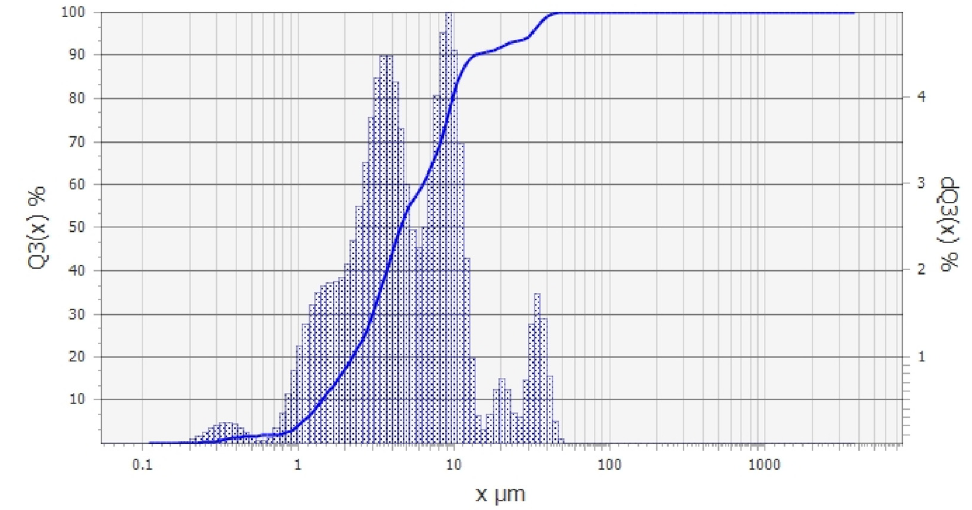
Figure 2. Granulometric analysis of the Pliocene clays used in the study.